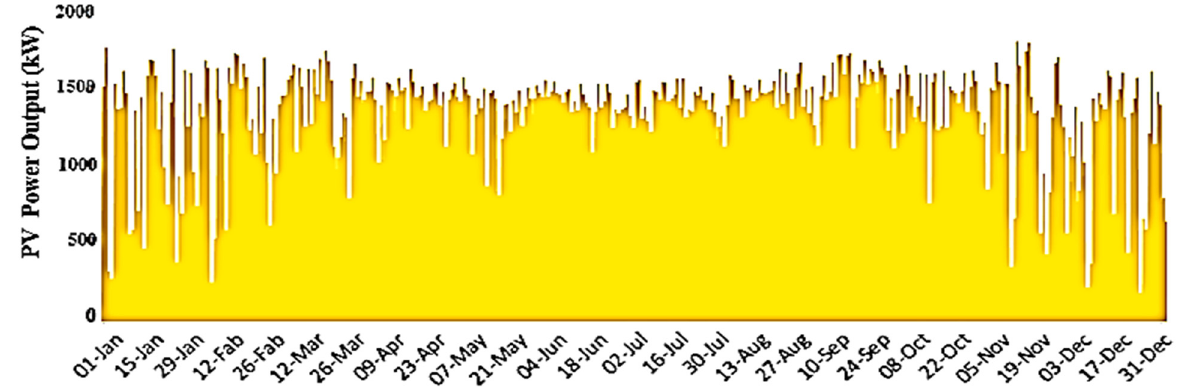
Figure 6. The yearly PV power output of the HRES for the proposed tourist village in the study.